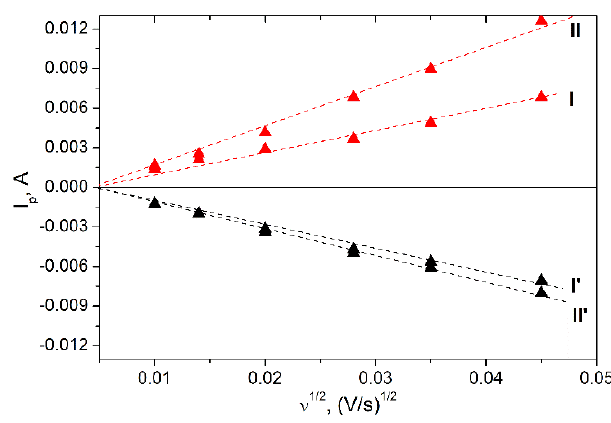
Figure 5. The dependence of current in CV maxima vs. square root of potential scan rate for Li 1.1 Mn 1.95 Co 0.025 Ni 0.025 O 4 (I, II corresponds to anodic peaks at 4.07 V and 4.18 V; I’ and II’ corresponds to cathodic peaks at 3.92 V and 4.07 V, respectively). Table 2. The calculated value of lithium ion diffusion coefficient in LiMn 1.95 Co 0.025 Ni 0.025 O 4 and